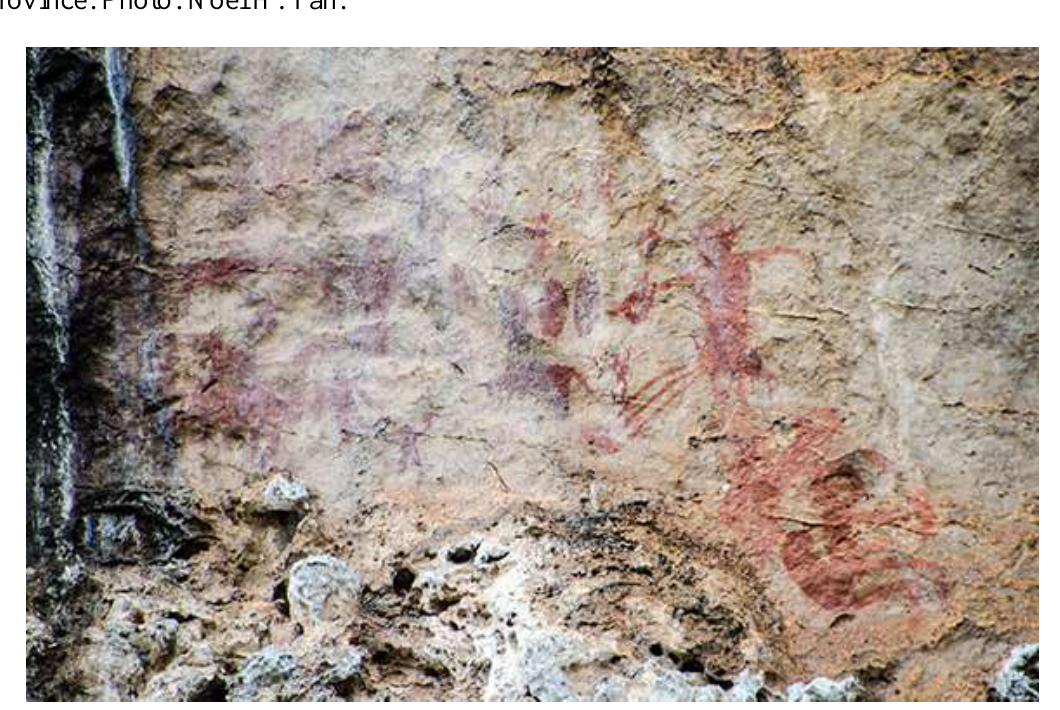
Figure 4. Rock art located on the cliff face outside the Pak Ou Caves in Luang Prabang Province. Photo: Noel H.